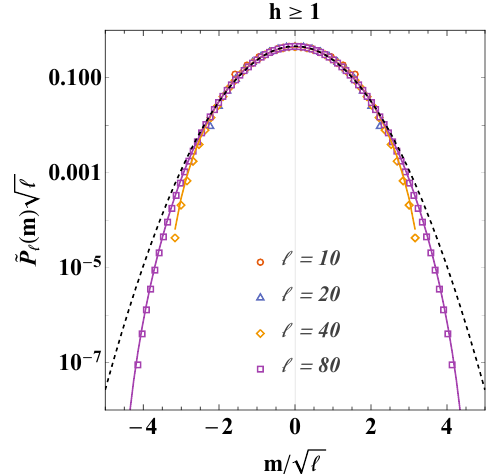
Figure 2: The rescaled PDF of the subsystem order parameter in the stationary state after quenching the transverse field into the paramagnetic region ( h ≥ 1.) Symbols are the exact results obtained from the exact generating function in Eq. (41); these are compared with the large deviation scaling obtained from Eq. (43) (full lines). The black-dashed line is the Gaussian approximation (44) valid in the thermodynamics